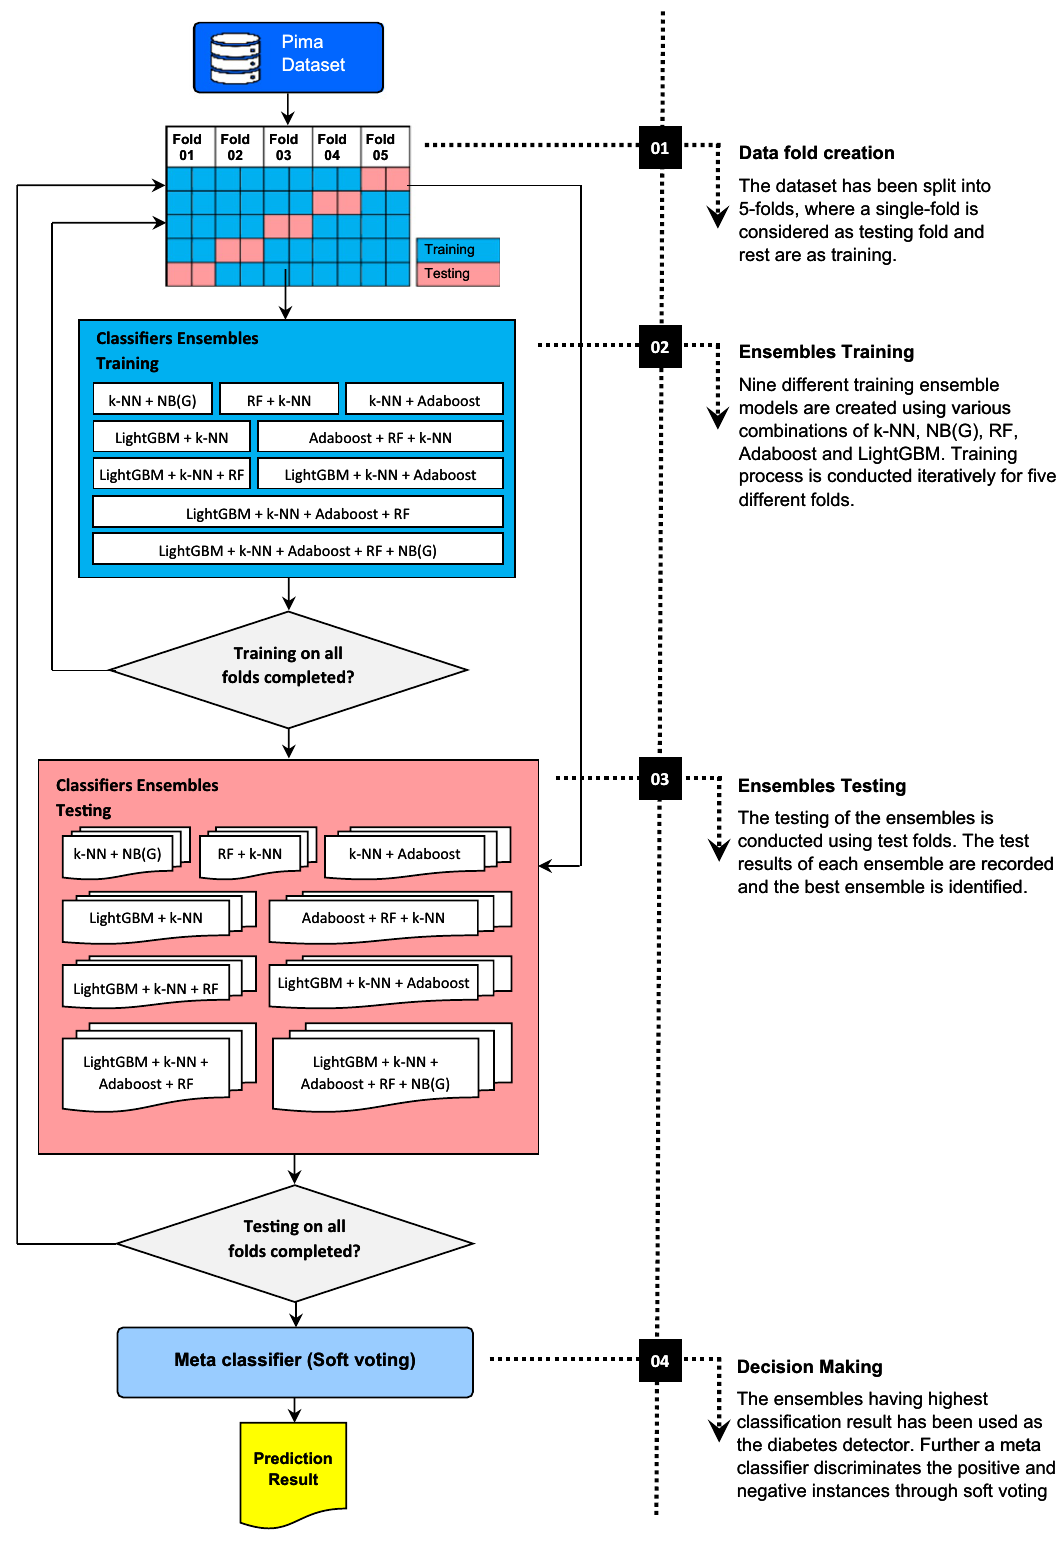
Fig. 1 The proposed ensemble diabetes detection